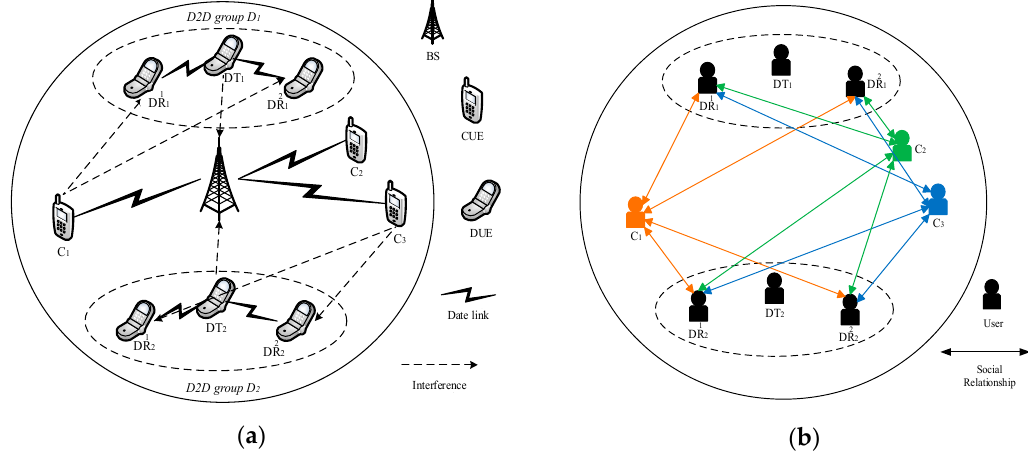
Figure 1. Two-layer system model: ( a ) Physical domain; ( b ) social domain.